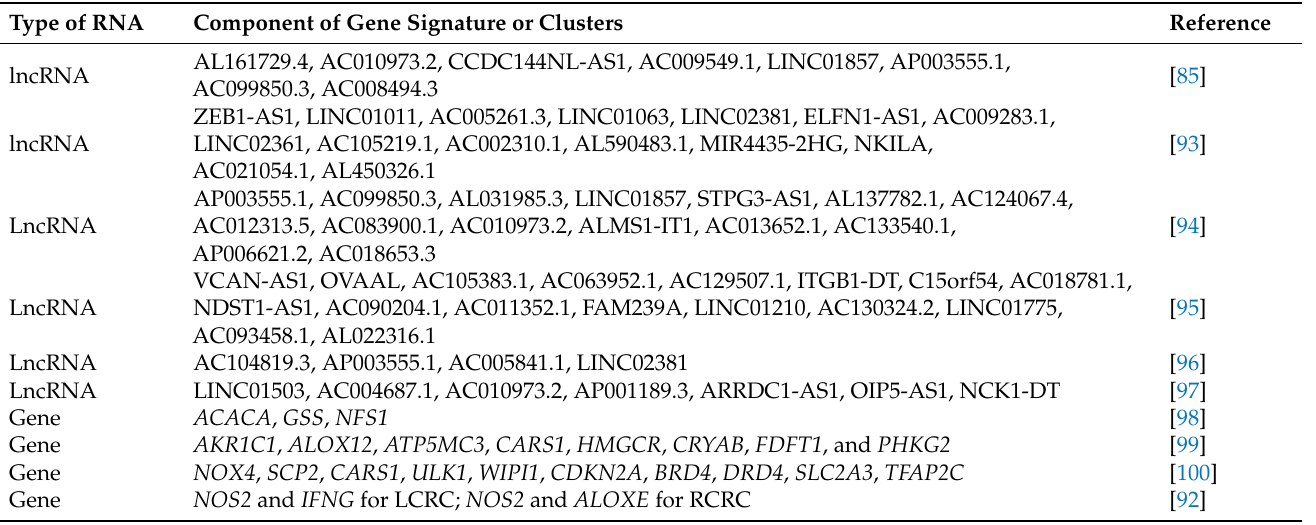
Table 2. Signatures or clusters that could predict the prognosis of